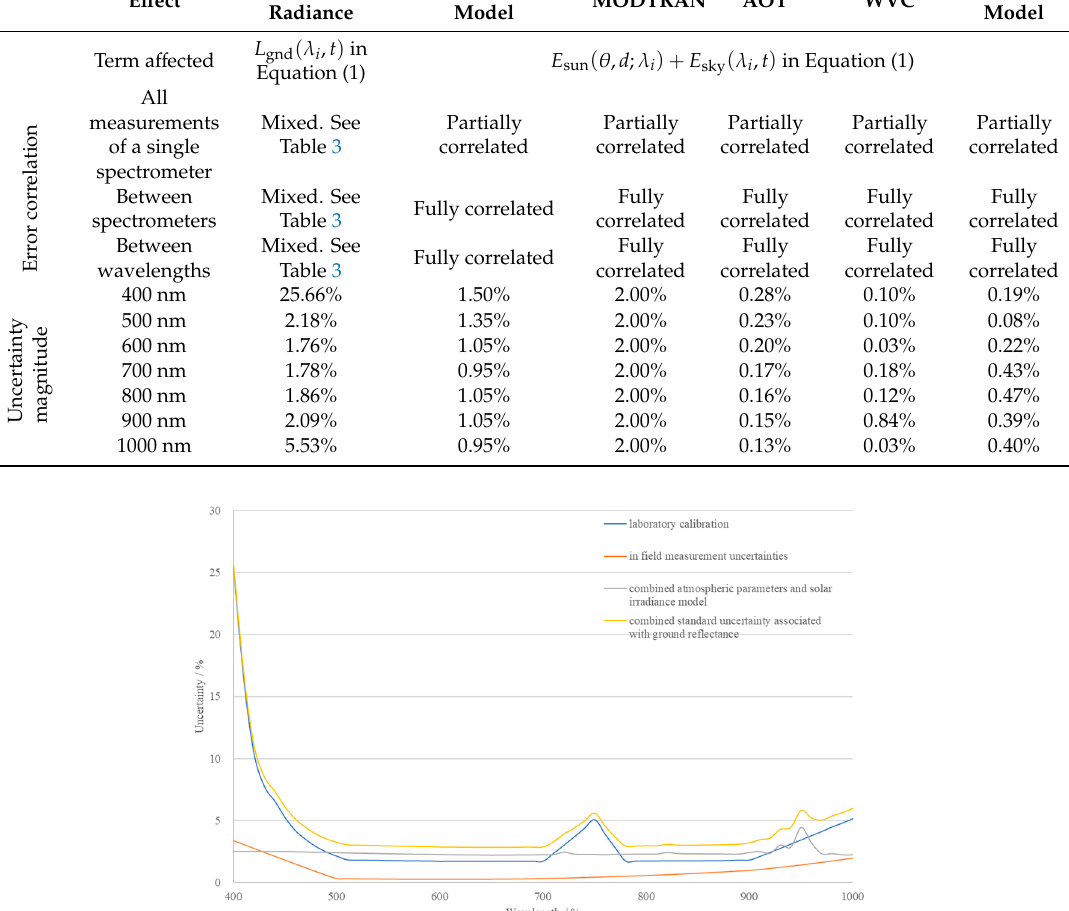
Table 4. The uncertainty associated with ground reflectance measured by the spectrometer. E ff ect